Question: In one sentence, what is this figure communicating?
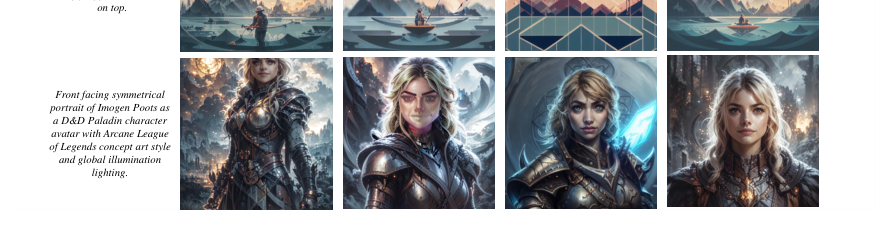
Answer: Comparison between images generated with Stable Diffusion tuned by DRTune or other baseline methods. Supervised by PickScore.